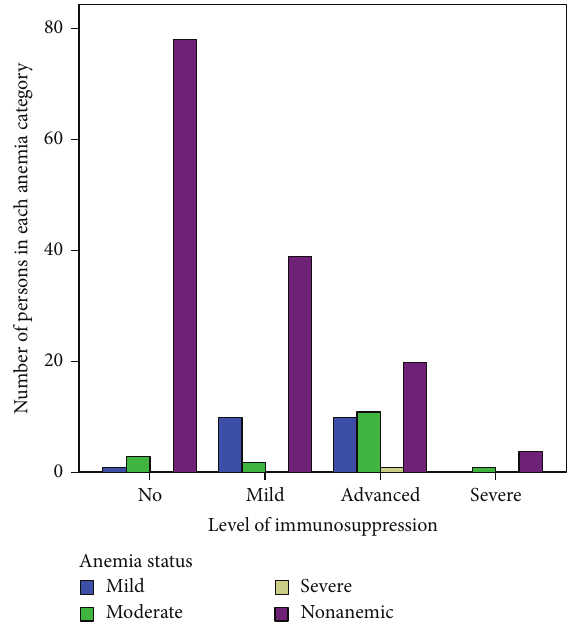
Figure 1: Distribution of anemia status by level of immunosup- pression in Zewditu Memorial Hospital, from August 5, 2013, to November 25, 2013, Addis Ababa,